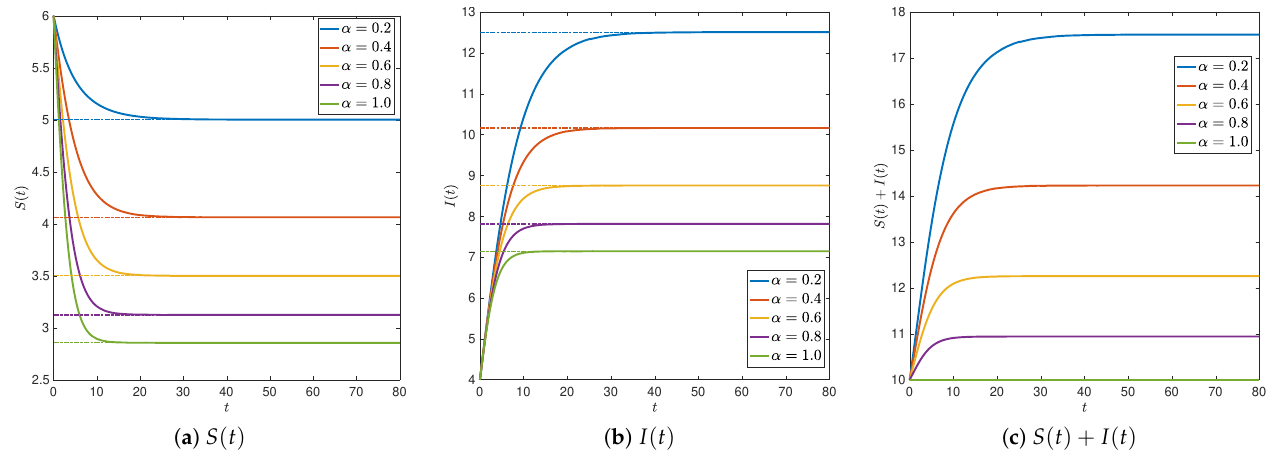
Figure 3. Numerical solutions to (2) for β = 0.7, γ = 0.2, S 0 = 6, I 0 = 4, and M ( α ) ≡ 1 as α changes.